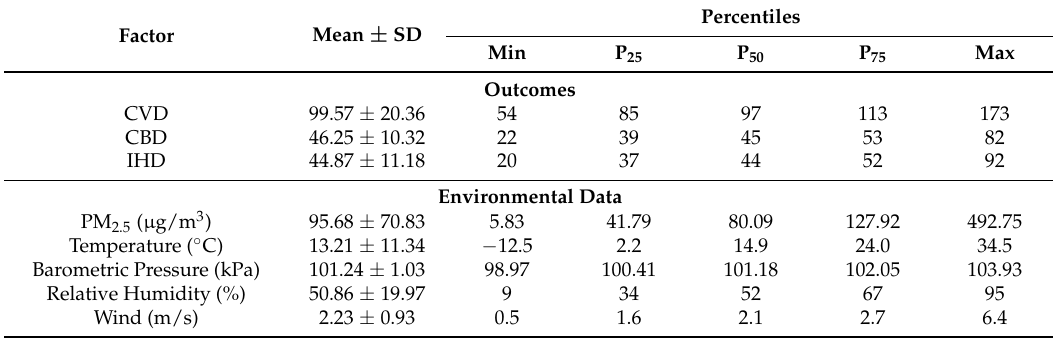
Table 1. Descriptive statistics of daily death counts, ambient air pollutants and meteorological factors in Beijing, China (2008–2011).